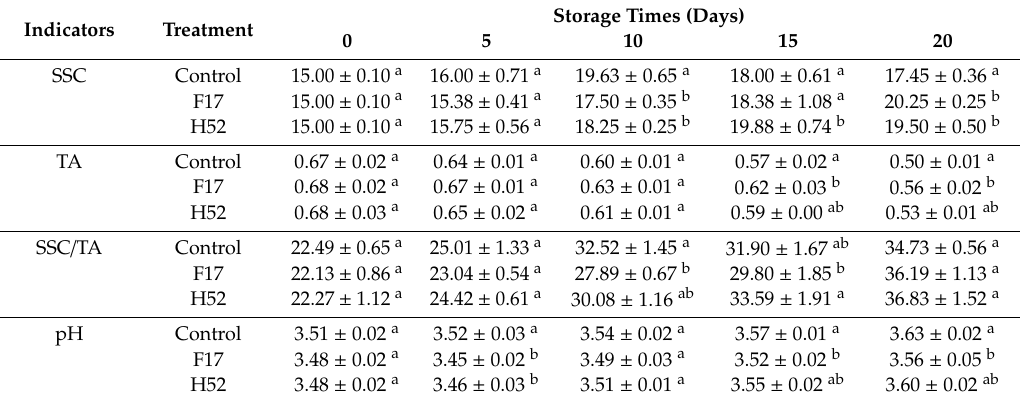
Table 1. SSC (%), TA (%), SSC / TA, and pH with di ff erent treatments on ‘Red Globe’ table grapes during storage at 25 ◦